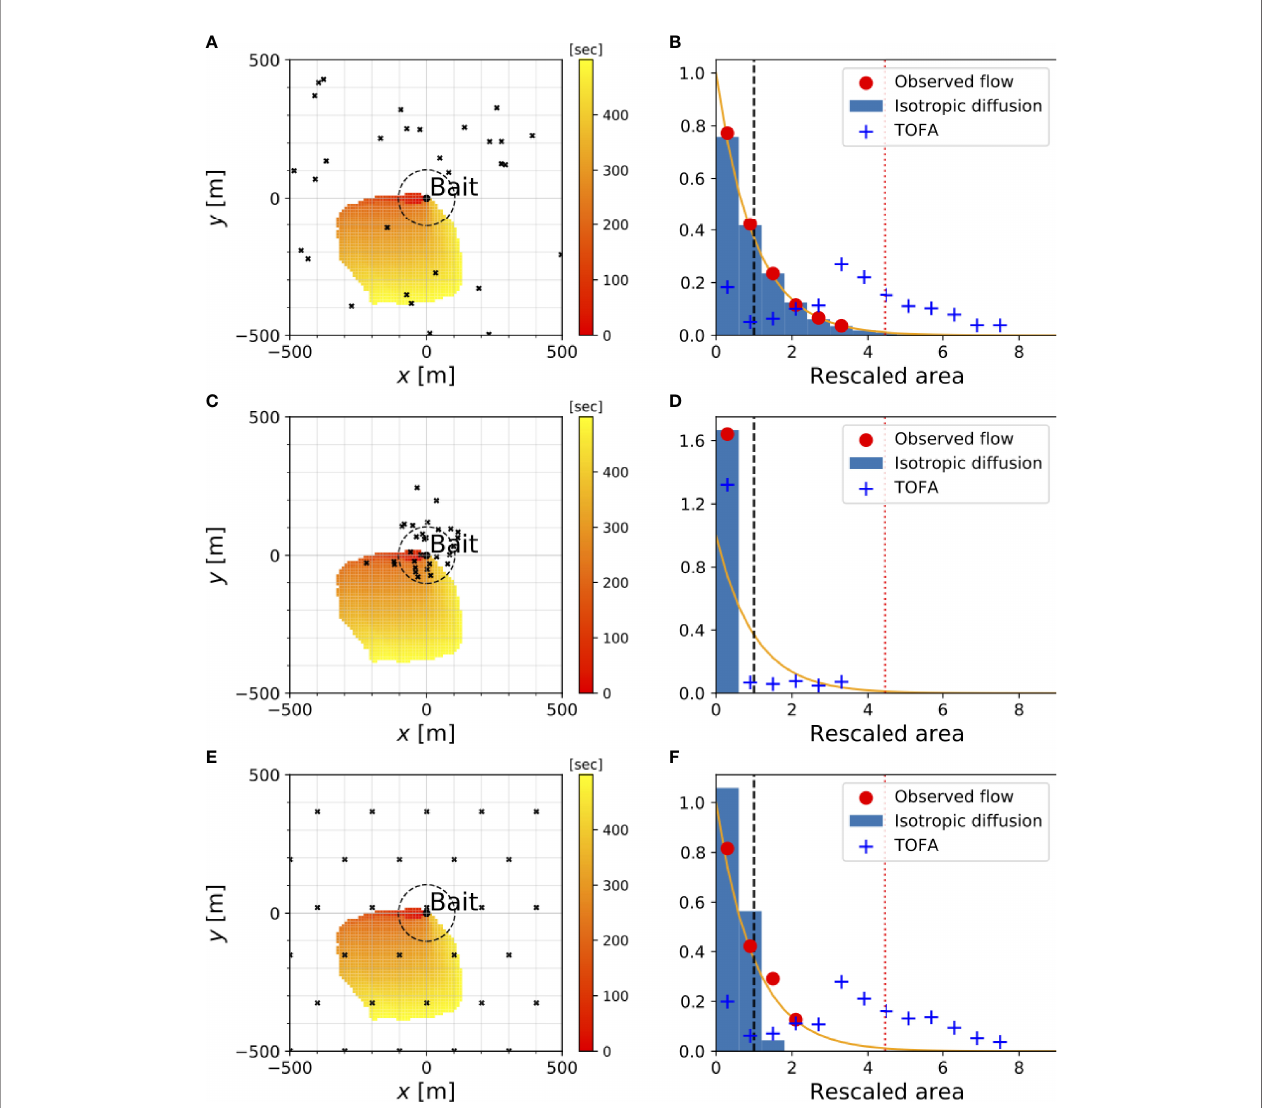
FIGURE 4 | Histogram of the area (B, D, F) estimated by the ODORA (observed fl ow and isotropic diffusion cases) and TOFA methods in idealized numerical simulations for different dispersion patterns (A, C, E) (top:random; middle:clumped; bottom:uniform). An example of fi sh positions for each dispersion pattern in the x-y square domain is shown by the black x ’ s; those for the uniform dispersion case denote the average over the experiments. Color shade shows the searched area obtained from the observed fl ow at each elapsed time. For the histogram, the lateral axis is the estimated area rescaled by r − 1 (nondimensional units) and the vertical axis is its occurrence frequency normalized so that its integral over the entire range of the rescaled area is unity. The dotted red line in the histogram is the maximum searched area for the case of the observed fl ow. The dashed black circles (A, C, E) and dashed vertical lines (B, D, F) denote the